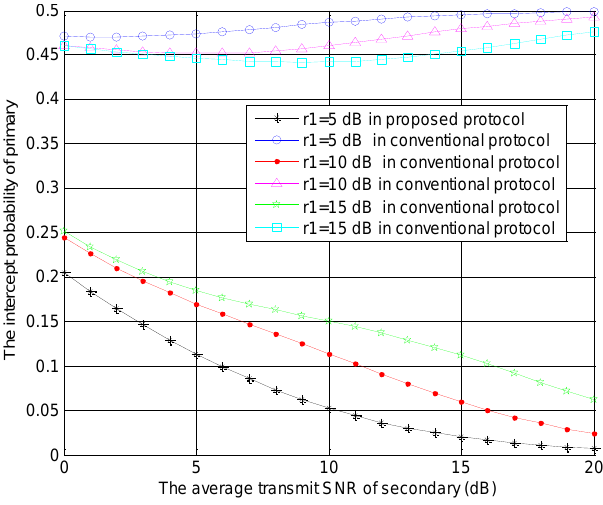
Figure 7. The intercept probabilities of primary users versus r 2 with different r 1